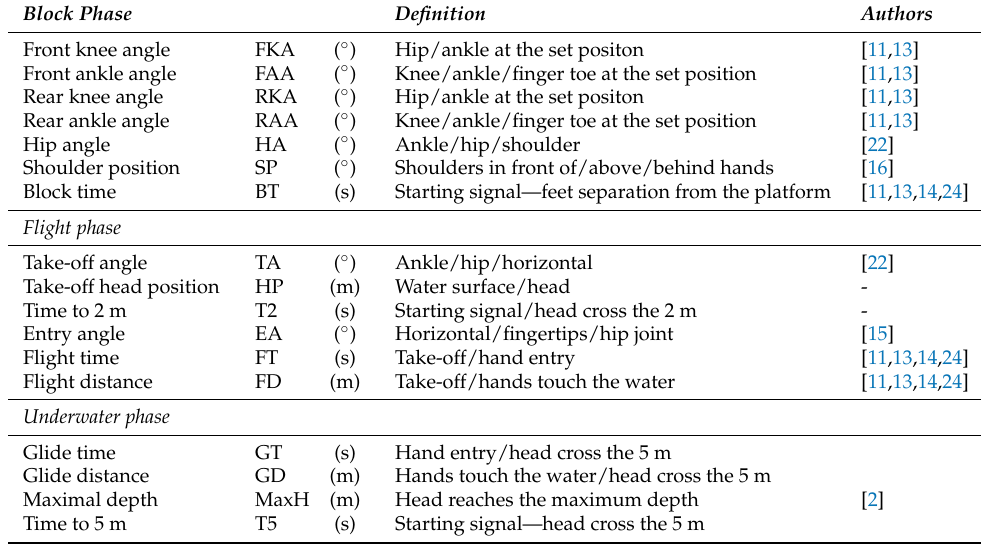
Table 1. Description of the kick start